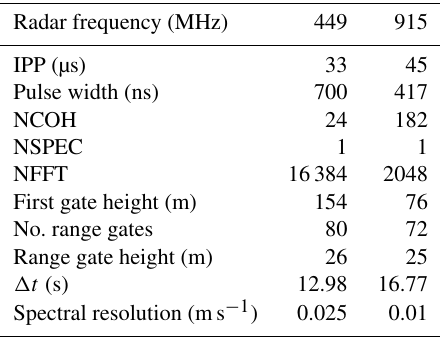
Table 1. Radar parameters for the 449 and 915MHz wind profiling radars, running in “turbulence mode” for minutes 25–55 of each hour during XPIA from 1 March to 30 April